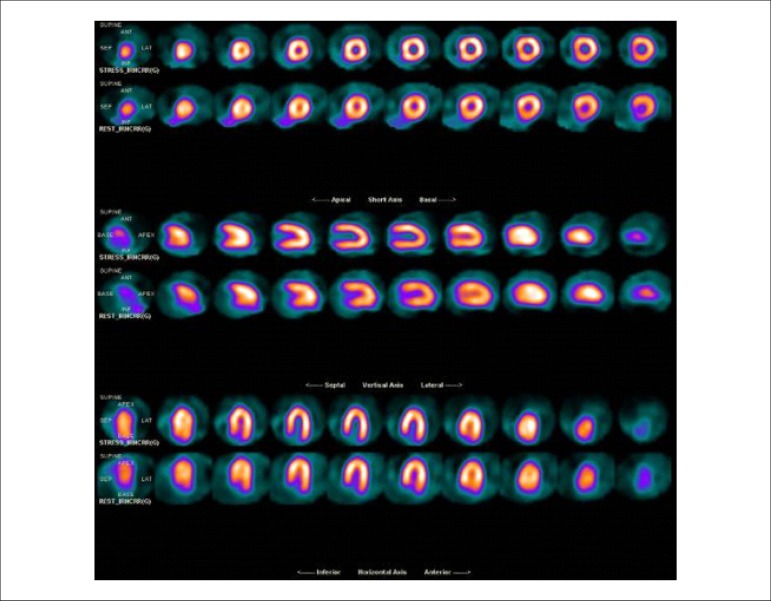
Case 10 - Myocardial perfusion scintigraphy with homogenous radiopharmaceutical distribution throughout the walls of the left ventricle, considered within the limits of normal. Images acquired with dedicated cardiac equipment (gamma camera), equipped with conventional sodium iodide crystals. Reproduced with the permission of Vitola JV.234